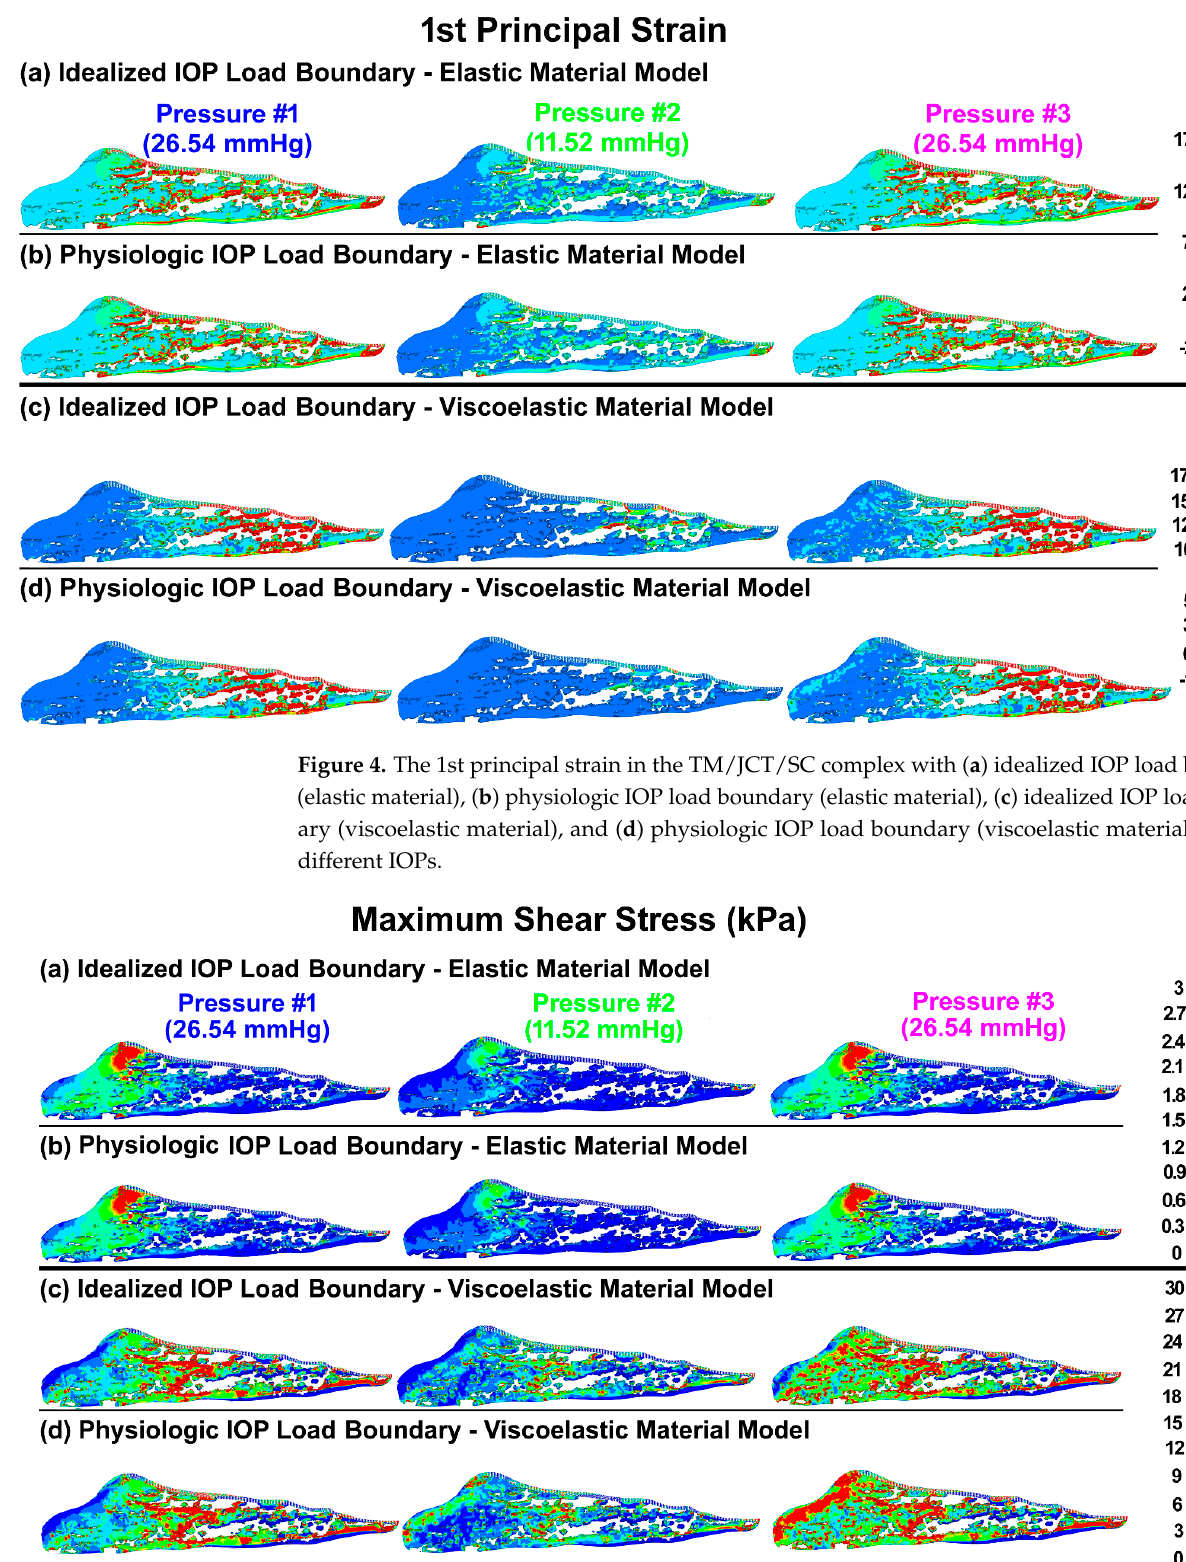
Figure 5. The maximum shear stress in the TM/JCT/SC complex with ( a ) idealized IOP load boundary (elastic material), ( b ) physiologic IOP load boundary (elastic material), ( c ) idealized IOP load boundary (viscoelastic material), and ( d ) physiologic IOP load boundary (viscoelastic material) at three different